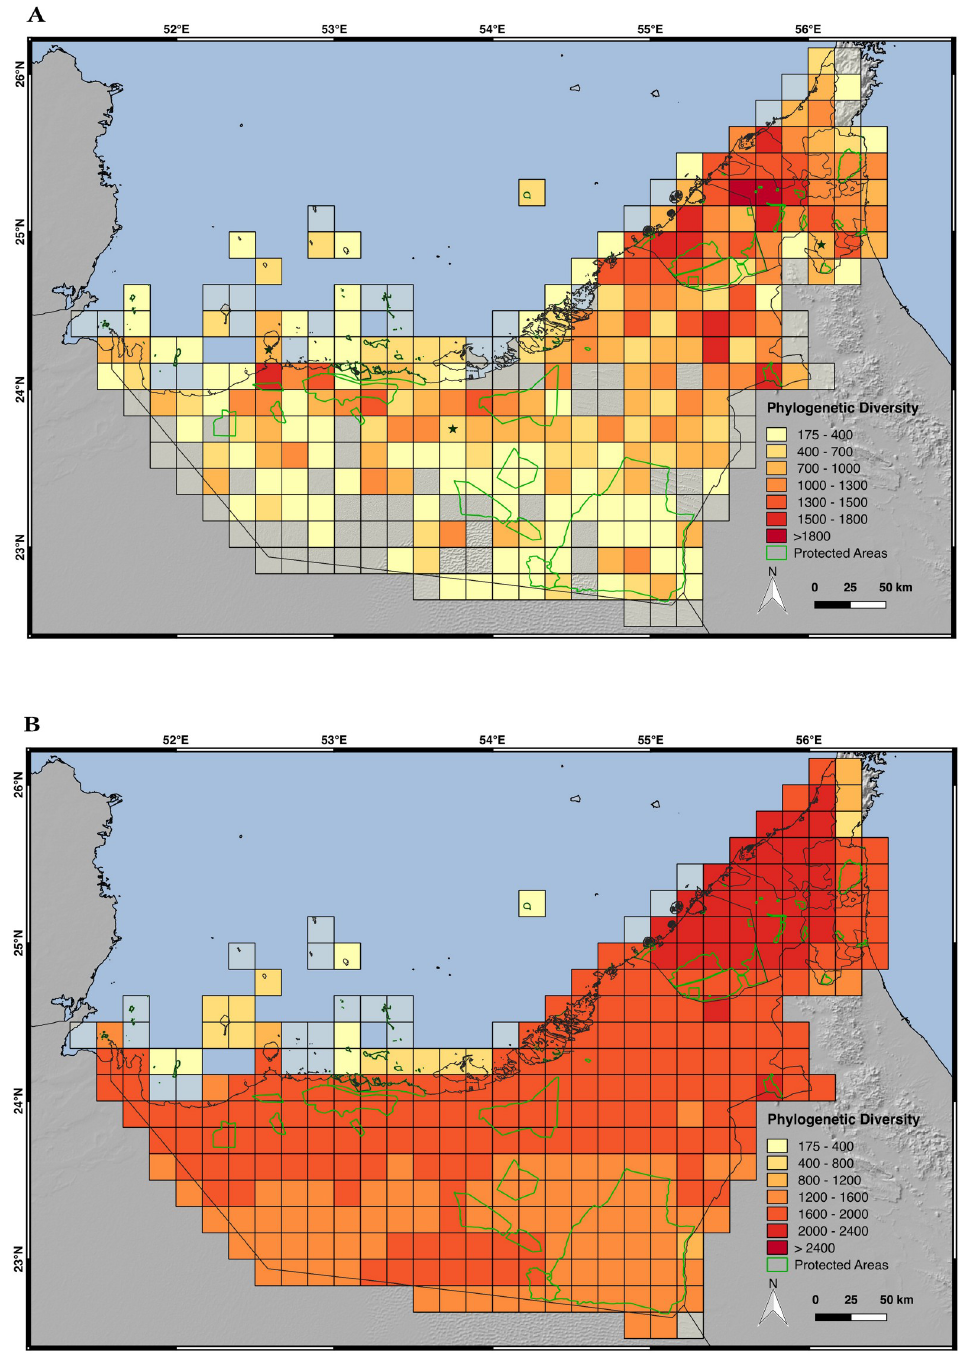
Fig 10. Maps of phylogenetic diversity (PD). A) PD by grid cells of 10 arc-minutes of longitude and latitude, using the area of occupancy of each species calculated with the occurrence point data; B) PD by grid cells of 10 arc-minutes of latitude and longitude inferred with the species distribution models; the terrestrial protected areas of the UAE are shown in light green; black stars represent the cells with values of PD significantly different than the expected by random. Only the 57 native species have been included in the analyses. Credits: OpenStreetMap contributors, SRTM.